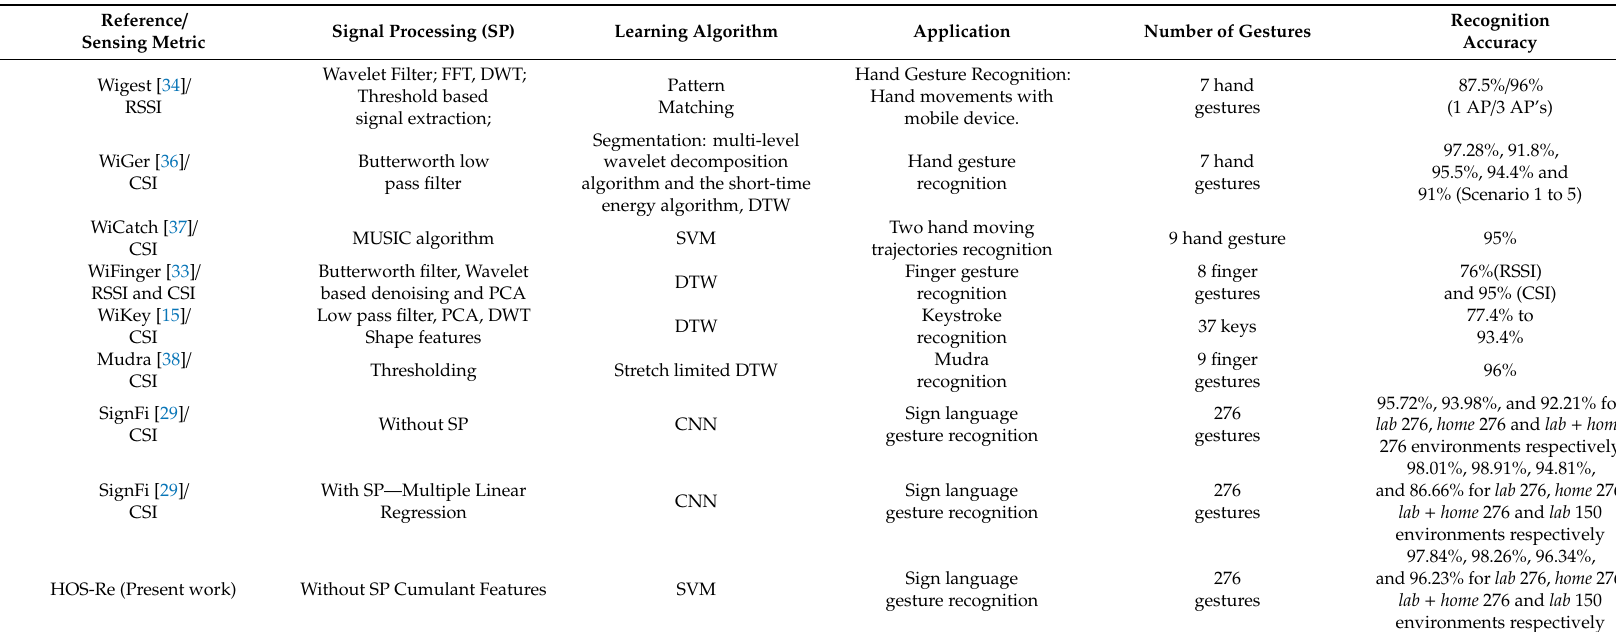
Table 4. Comparison of recognition accuracy of systems using COTS Wi-Fi